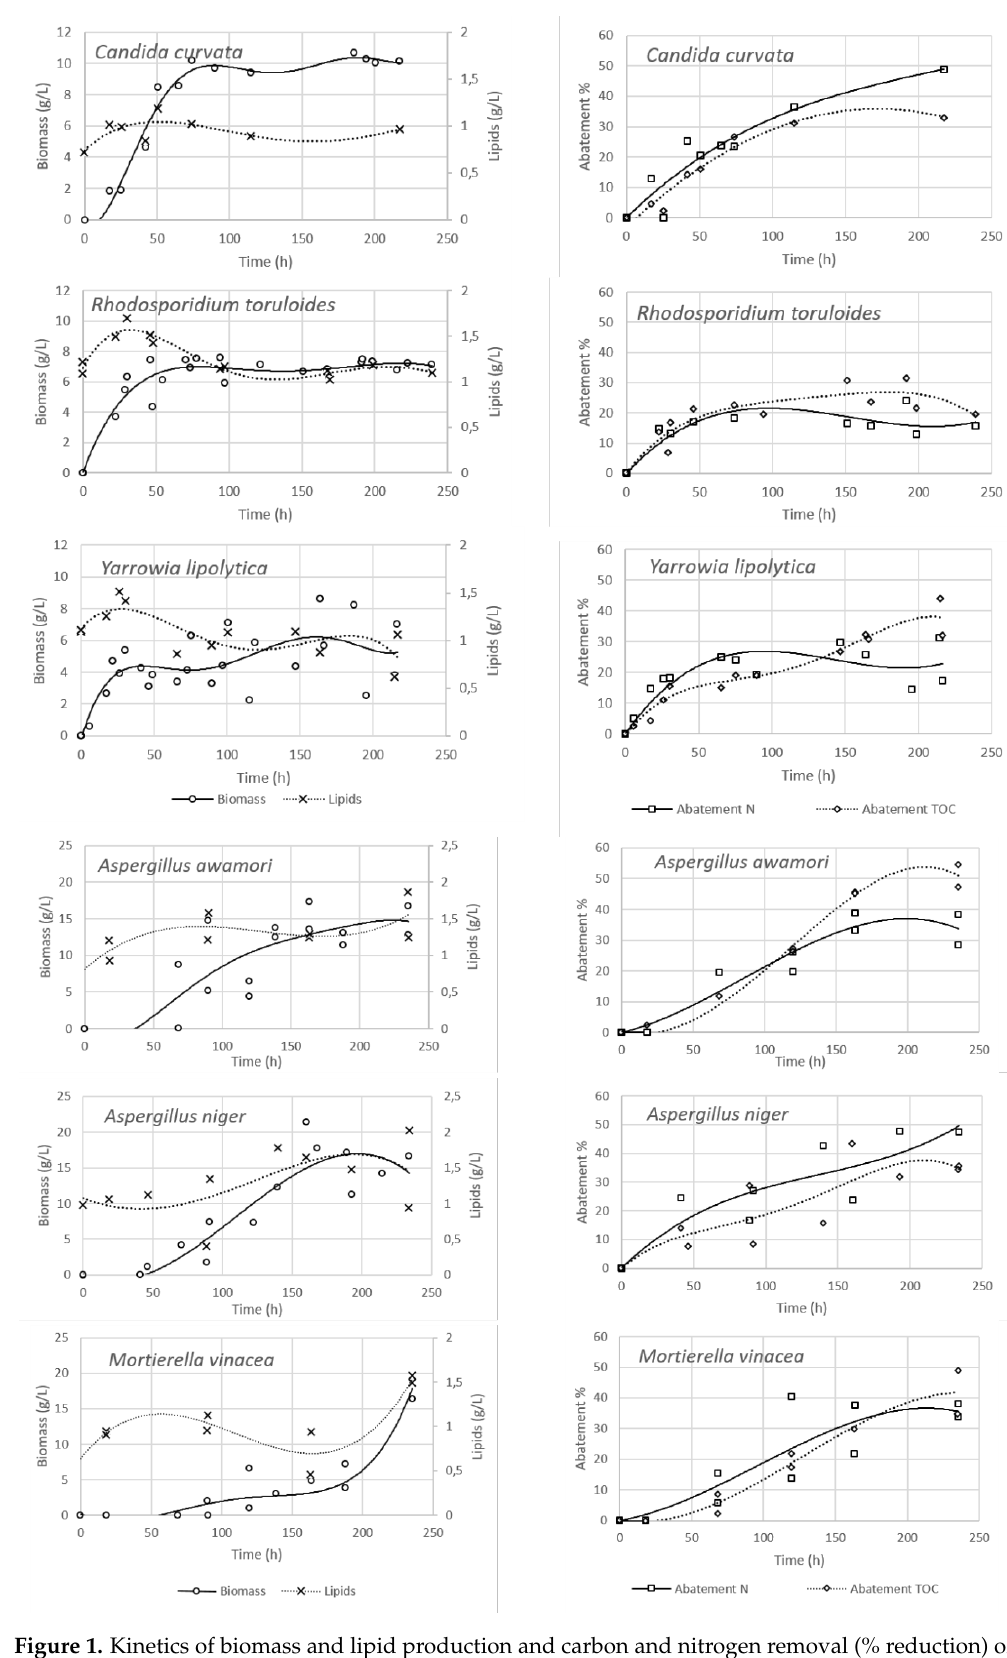
Figure 1. Kinetics of biomass and lipid production and carbon and nitrogen removal (% reduction) of six selected strains during growth on crude vinasse media.